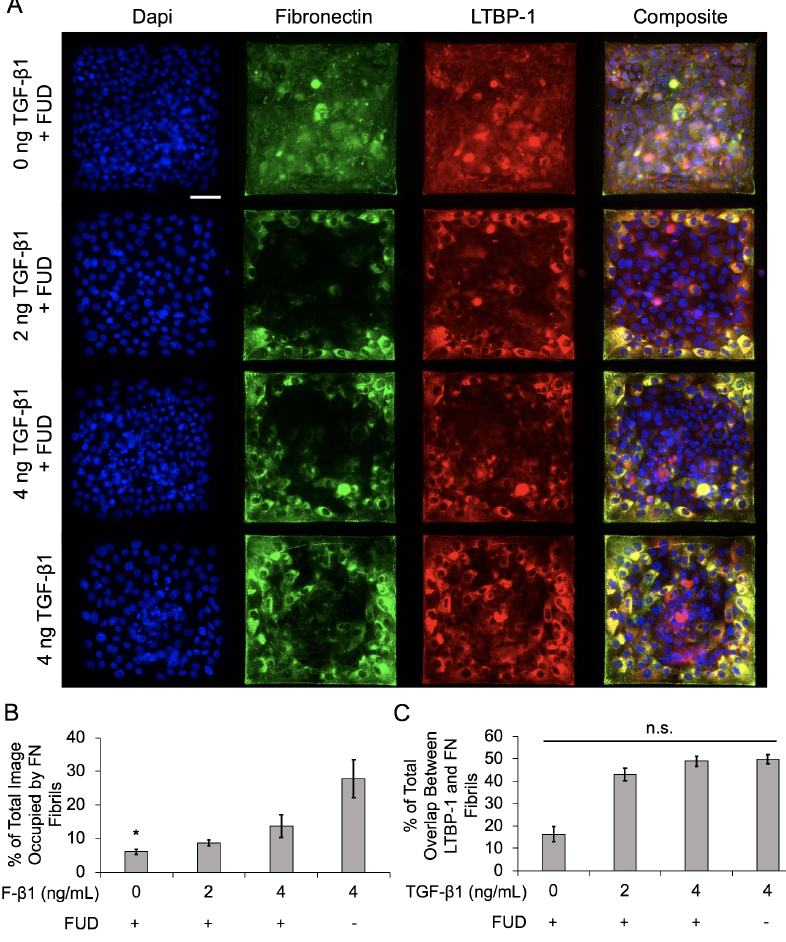
Figure 7. Inhibition of FN fibrillogenesis decreases overall FN assembly but does not affect LTBP-1 colocalization with FN fibrils in MCF10A square islands with increasing TGF- β 1 concentration. ( A ) Immunofluorescence images of MCF10As after 48 h of treatment with FUD and increasing concentrations of TGF- β 1. Ab staining for nuclei (blue), FN (green), and LTBP-1 (red). Composite displays colocalization of FN and LTBP-1 in yellow. Scale bar 50 mm. ( B ) Quantification of percentage of image occupied by FN fibrils. N = 3 for each condition. ( C ) Quantification of colocalized LTBP-1 on FN fibrils. N = 3 for each condition. * p ≤ 0.05 significantly different from positive control only, 4 ng/mL TGF- β 1. p -values based on Bonferroni’s post-hoc multiple comparisons test following one-way